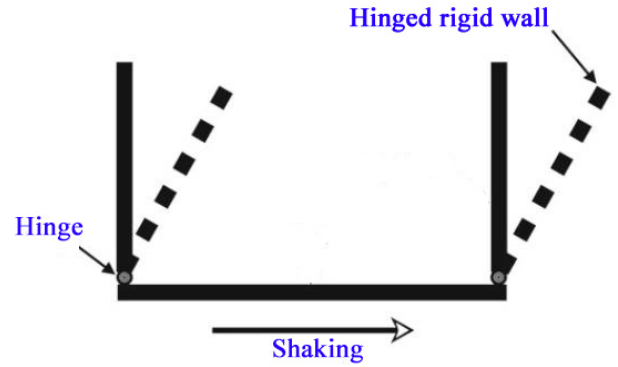
Figure 4. Schematic diagram of rigid container with hinged end-walls (from [29]; modified).